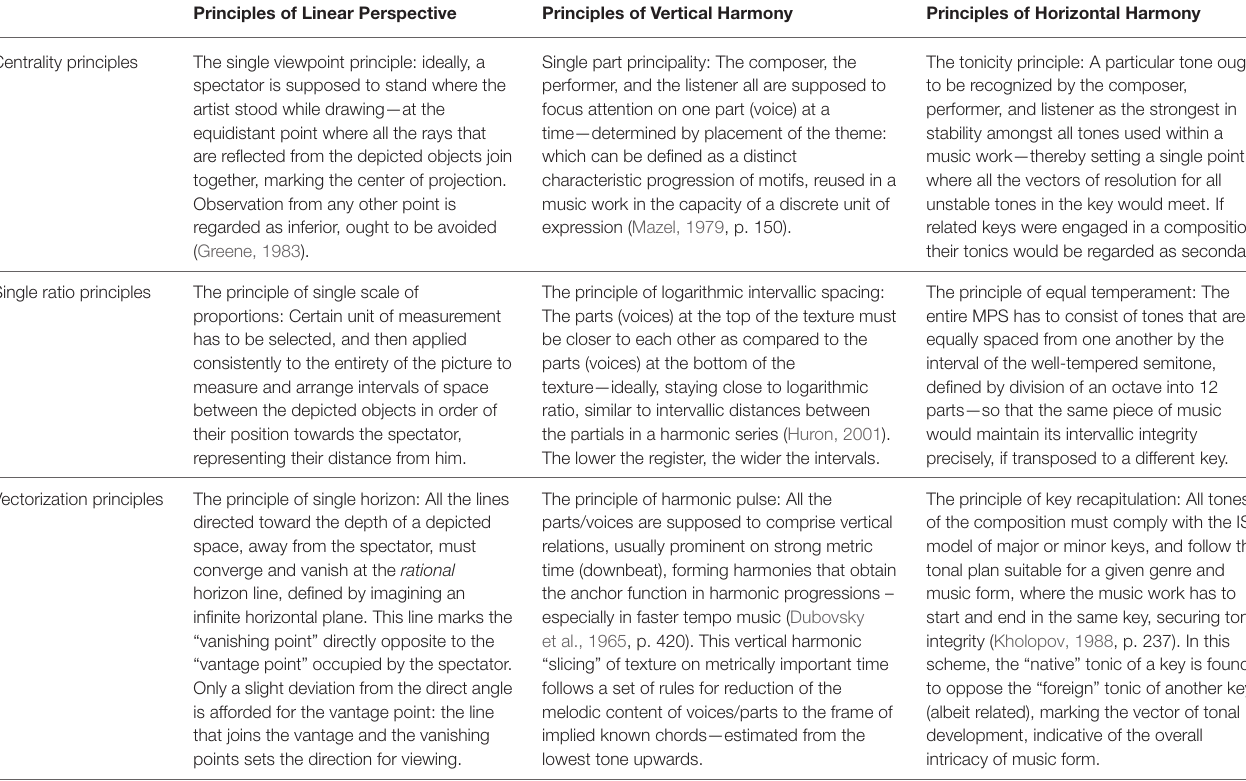
Table 1 | Correspondence of principles of canonic linear perspective and principles of eighteenth century Western